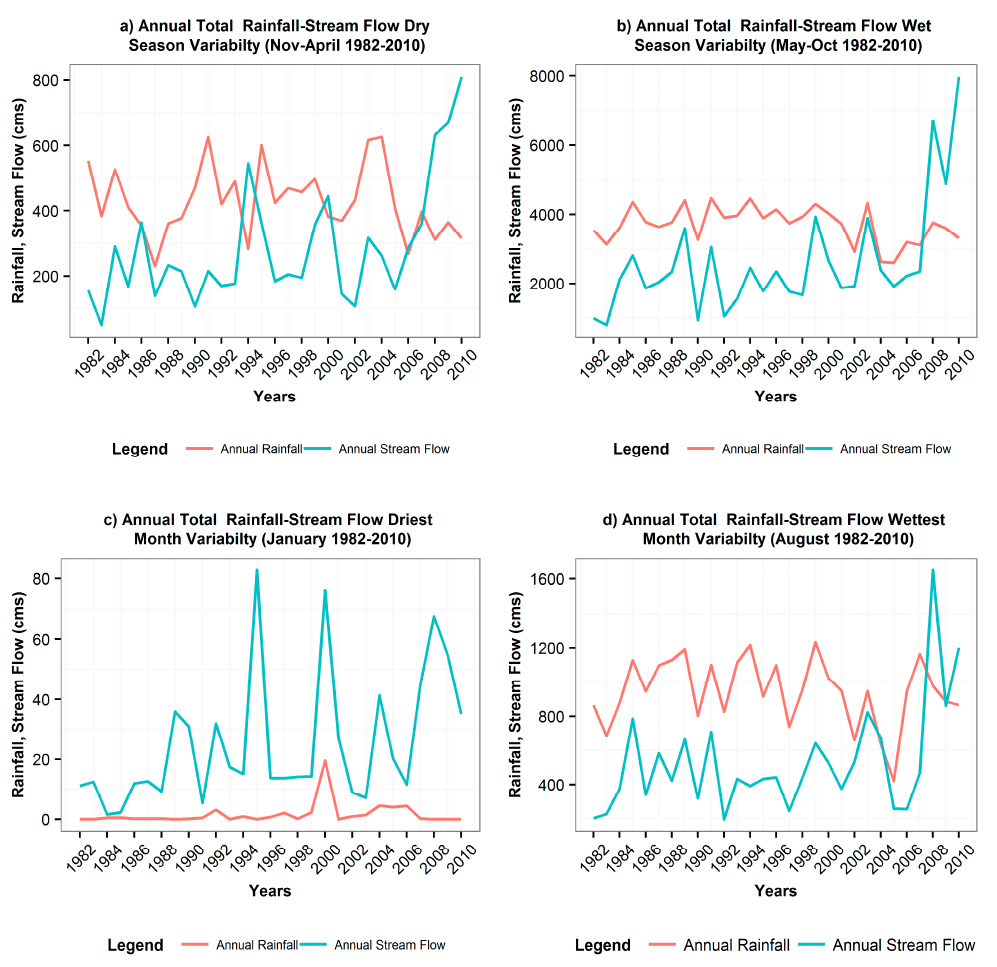
Figure 5. Seasonal variation of rainfall-stream flow.